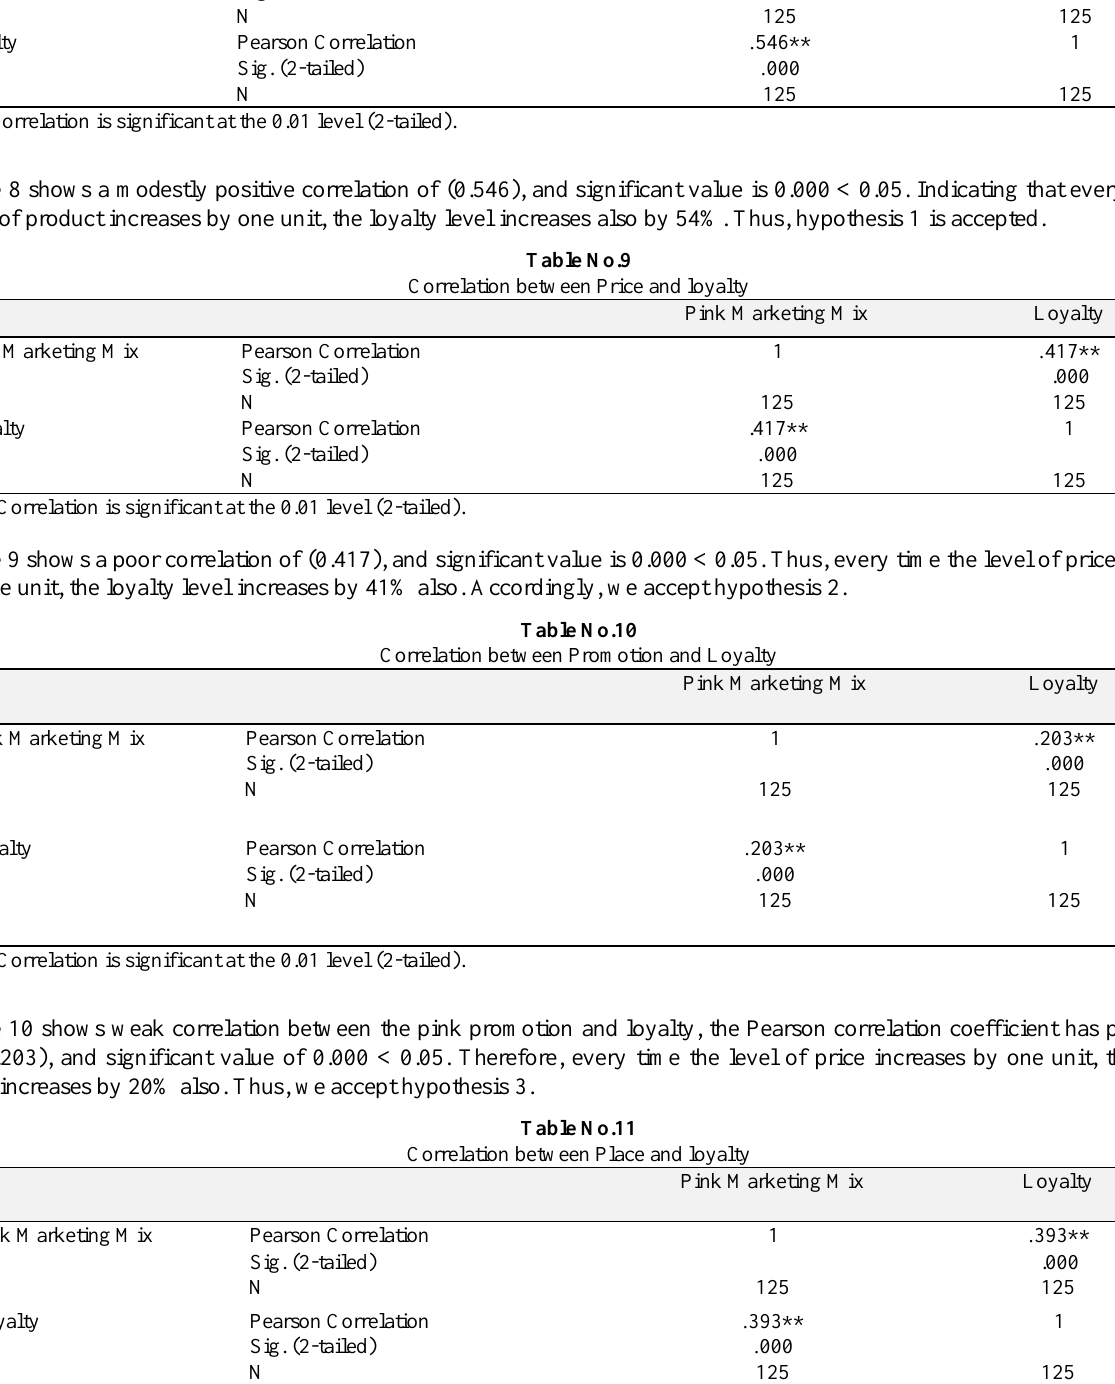
Pink Marketing Mix Pearson Correlation